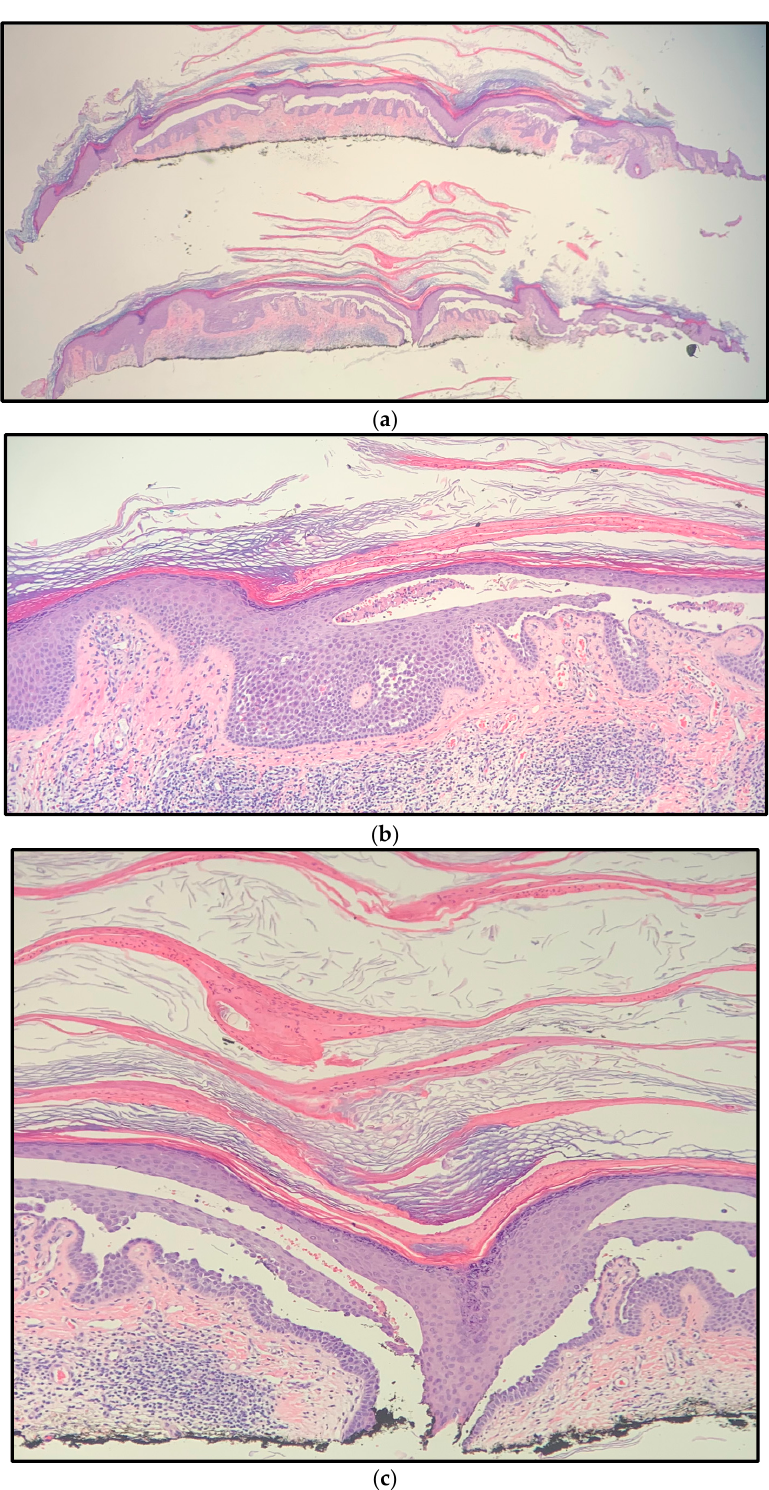
Figure 2. Right mid-back shave biopsy histology (hematoxylin and eosin) showing hyperkeratosis, acanthosis, focal hypergranulosis, and acantholysis extending down a hair follicle versus elongated, broad rete at magnification: ( a ) ×10; ( b ) ×20; ( c ) ×40.